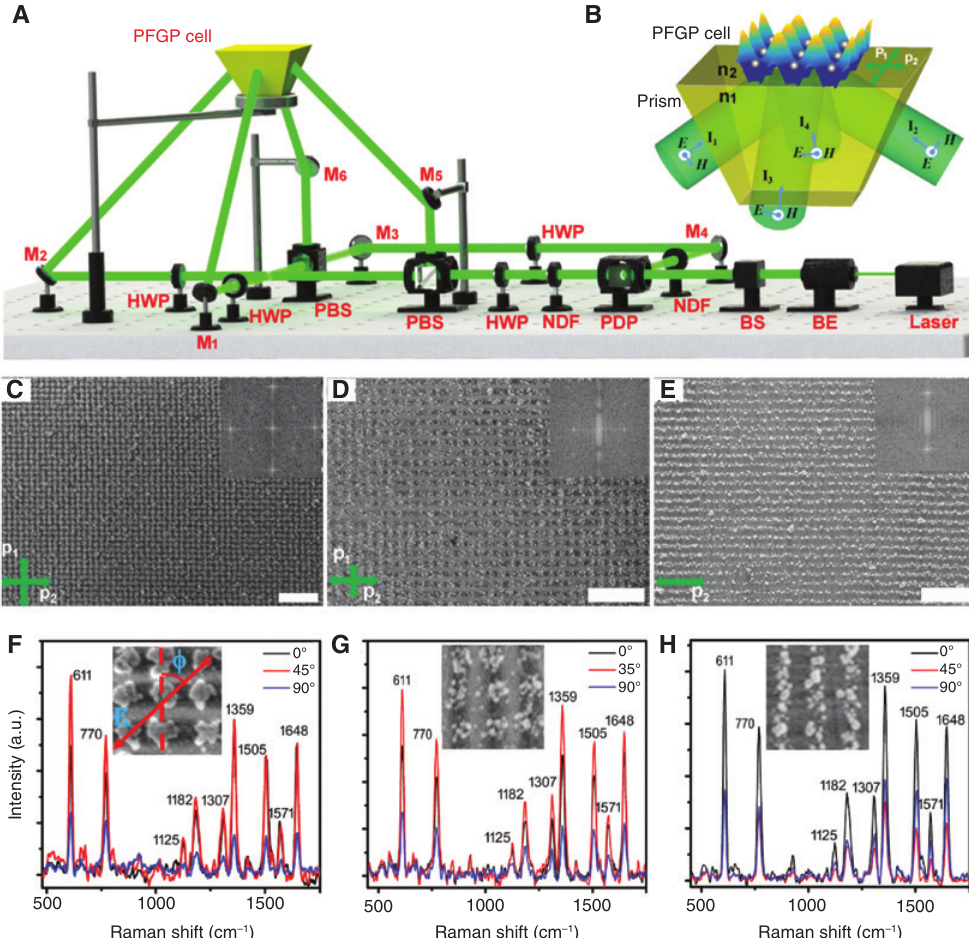
Figure 1: Illustration of the optical setup for PFGP and the SEM images of the patterned colloidal silver nanostructures with anisotropic spectral